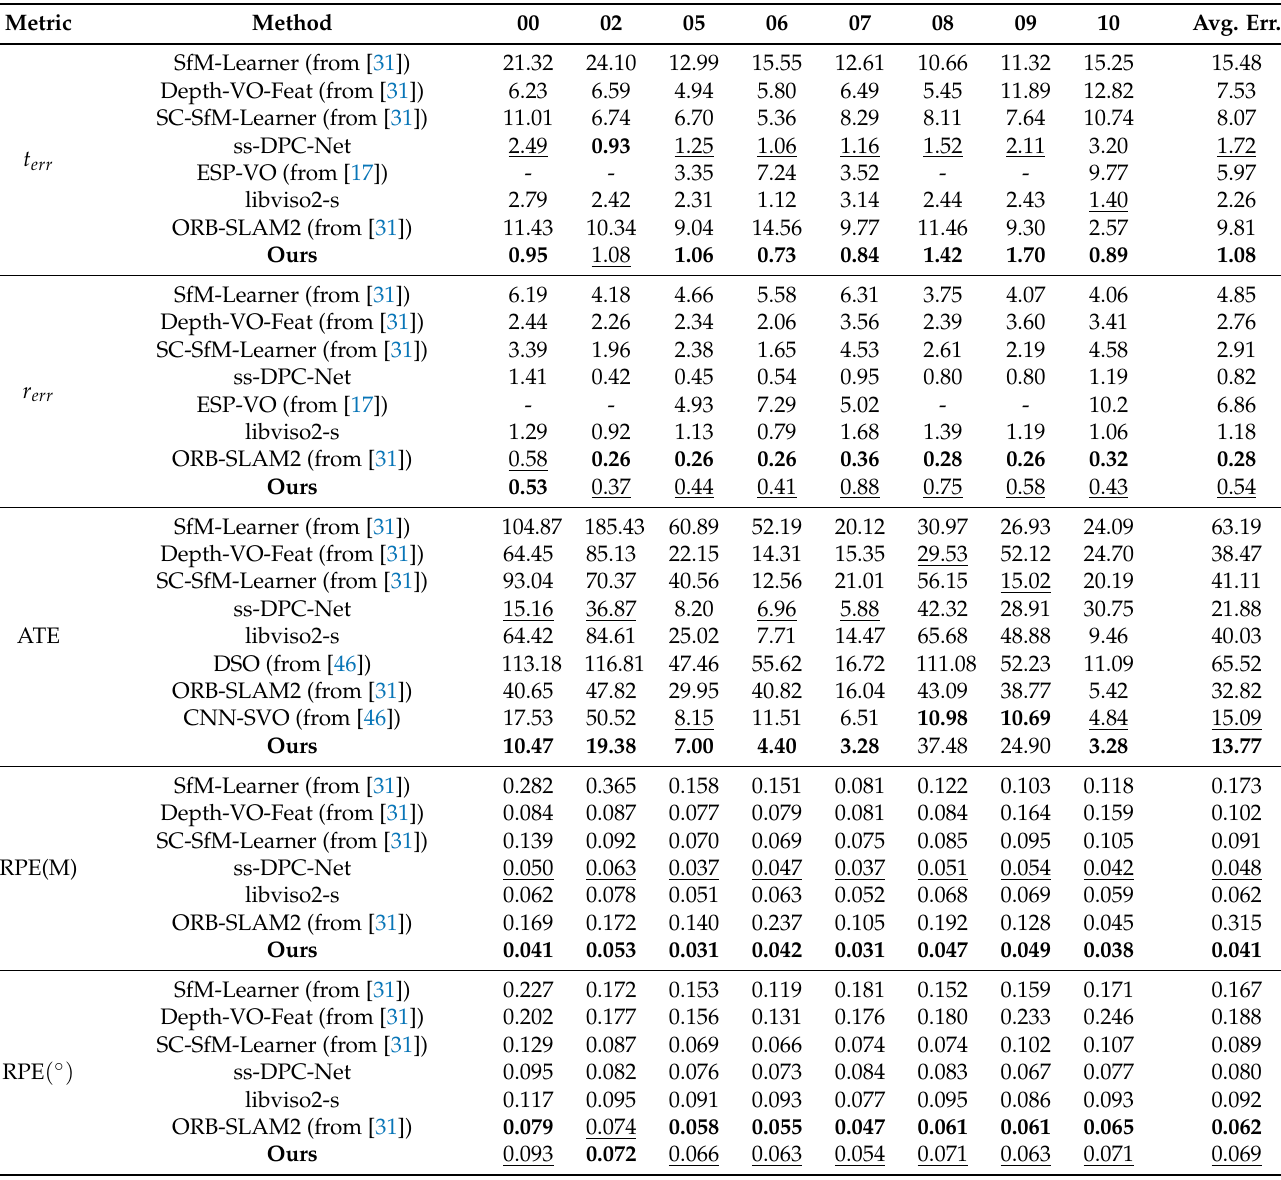
Table 1. Quantitative results on KITTI Odometry Sequence 00, 02, 05-10. The best result is in bold, and the second best is